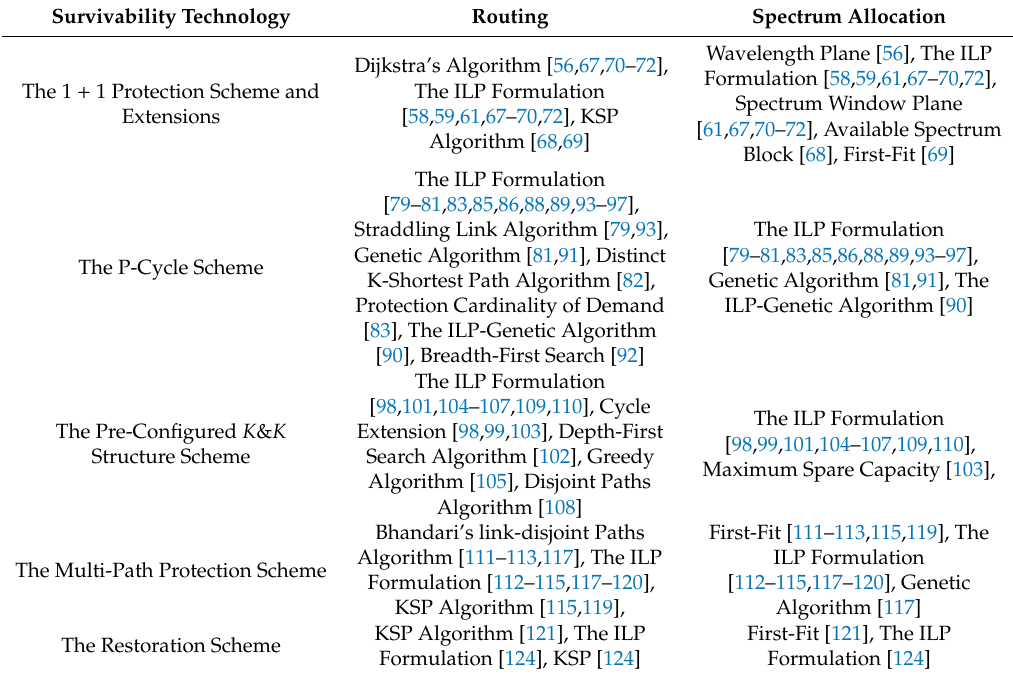
Table 3. Technologies used to conduct routing and spectrum allocation in backup paths.